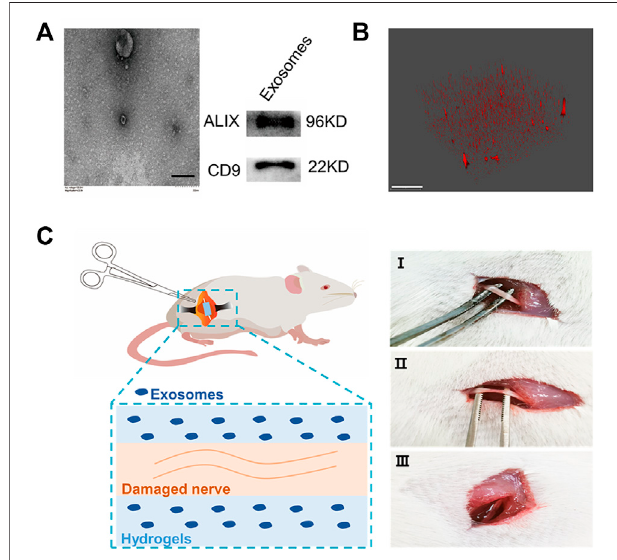
FIGURE 1 | Hydrogel-loaded exosomes for the treatment of sciatic nerve injury. (A) Characterization of human umbilical cord – derived mesenchymal stem cell – derived exosomes (left: TEM of exosomes, bar = 200 nm; right: Western blot characterization of exosome marker proteins). (B) Fluorescence 3D imaging of hydrogels loaded with PKH26- labeled exosomes (red: PKH26, bar = 50 μ m). (C) Rat SNCI model. Different concentrations of HAMA solution mixed with exosomes were injected into the injured nerve, and after curing with ultraviolet light, the hydrogels with different mechanical properties were formed at the nerve injury site (I, uninjured rat sciatic nerve; II, injured sciatic nerve; and III, injured nerve embedded in